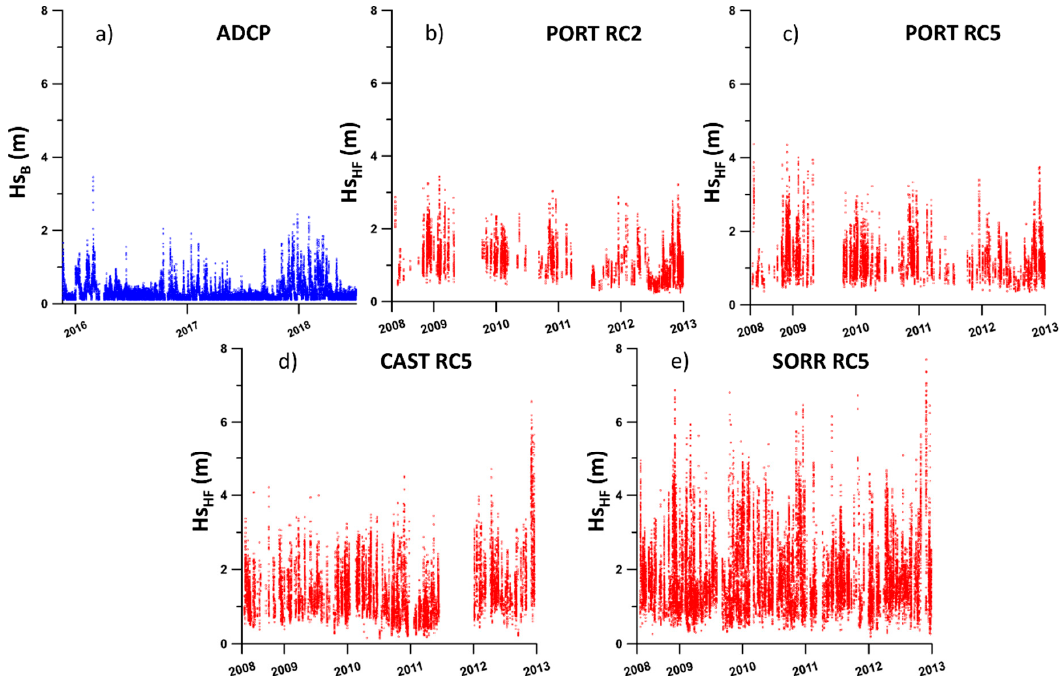
Figure 2. Hs time series for the ADCP (Hs B ; blue, panel a ) and the three HF radar sites (Hs HF ; red, panels b – e ). For the PORT site, the Hs HF values recorded both at RC2 and RC5 are plotted.